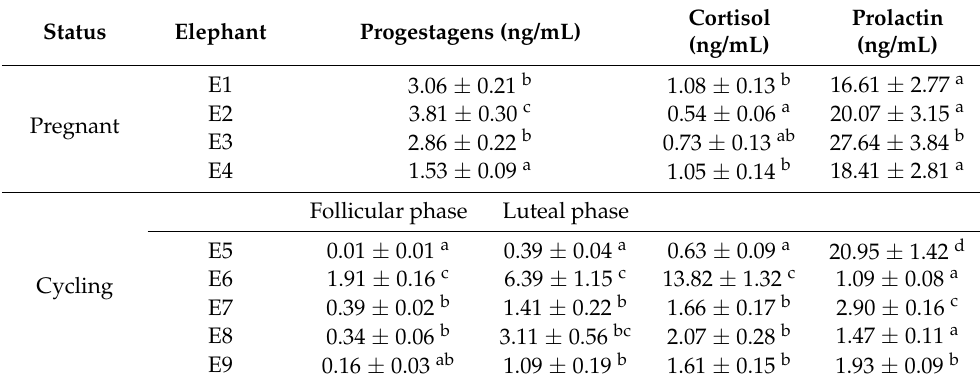
Table 3. Individual mean ( ± SEM) progestagens, cortisol, and prolactin concentrations in pregnant and cycling elephants. Status Elephant Progestagens (ng/mL)